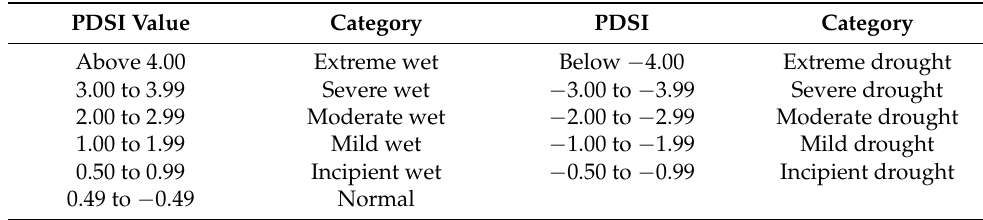
Table 1. Classification of the PDSI values. PDSI Value Category PDSI Category Above